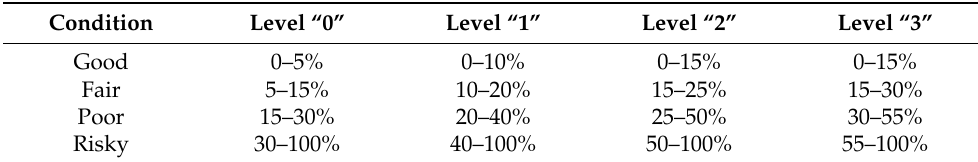
Figure 3. The distribution of device criticality in the study group. Each of the criticality levels has individual score assessment criteria. The thresholds were set as the percentage value of the obtainable score, which for a score of 0 points corresponds to 0% while 10 points is 100% of the achievable value. The evaluation scale used in the presented algorithm is a four-grade type (good, fair, poor, risky) and the detailed thresholds are presented in Table 9. Table 9. The condition rating based on the percentage value of the health index score and the device criticality.